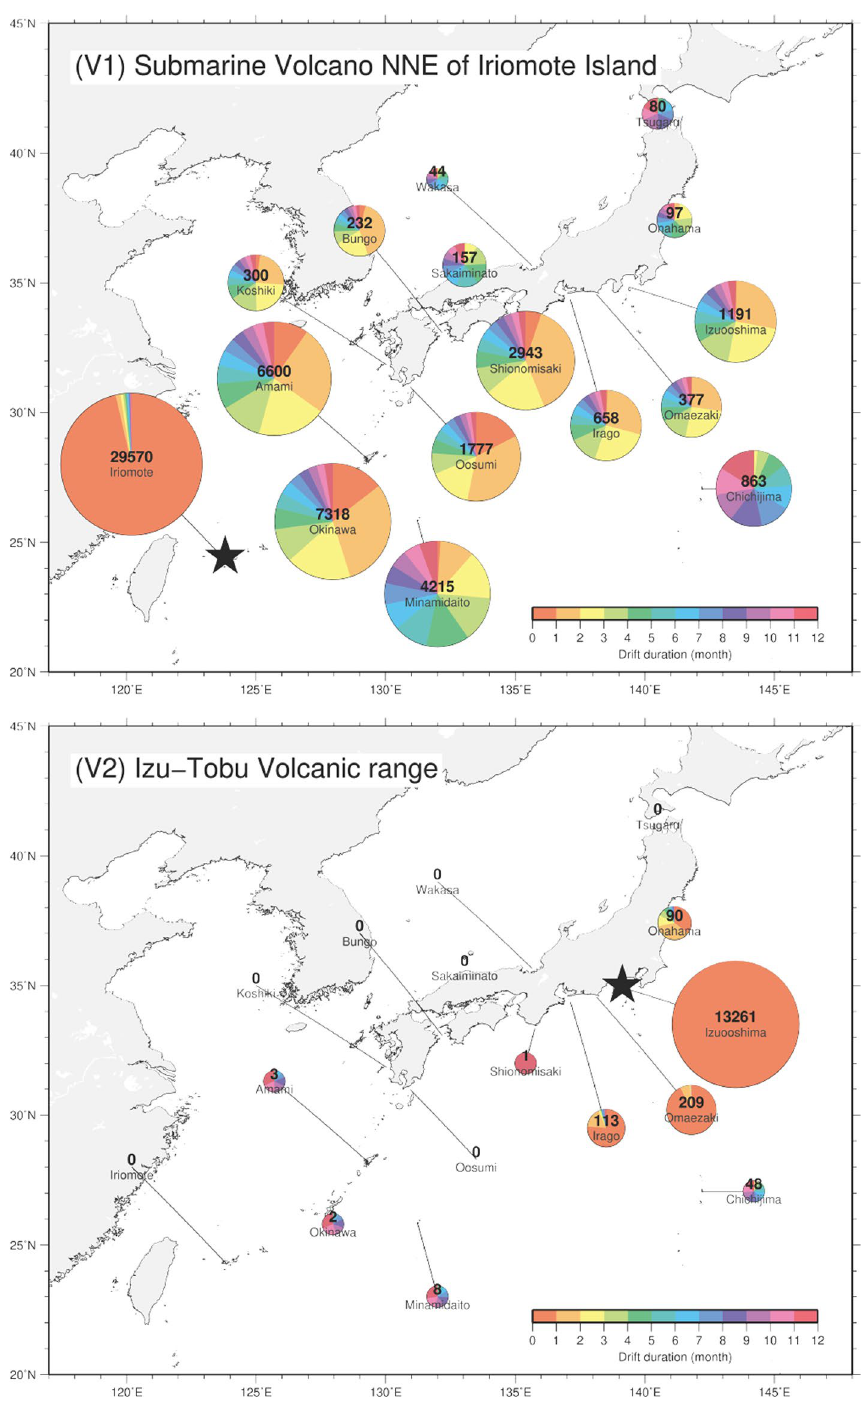
Fig. 5 The average number of virtual pumice clasts arriving at each target area after being released from (V1) the submarine volcano NNE of Iriomote Island, (V2) the Izu-Tobu volcanic range, (V3) Miyakejima, (V4) Bayonnaise Rocks, (V5) Nishinoshima, (V6) Kaitoku Seamount, and (V7) Fukutoku-Oka-no-Ba. In each frame, the black star represents the location of the volcano source. The numbers reported were averaged over all simulations; for example, an average of 7318 of the total 49,000 virtual pumice clasts released from the submarine volcano NNE of Iriomote Island were transported to Okinawa per simulation. The radii of the pie charts are proportional to the logarithm of the average number of virtual pumice clasts that arrived at each target area. The color scale of the pie charts indicates the average drift duration of each proportion of the virtual pumice clasts that arrived. If the mean number of virtual pumice clasts was below 1, a value of 0 is